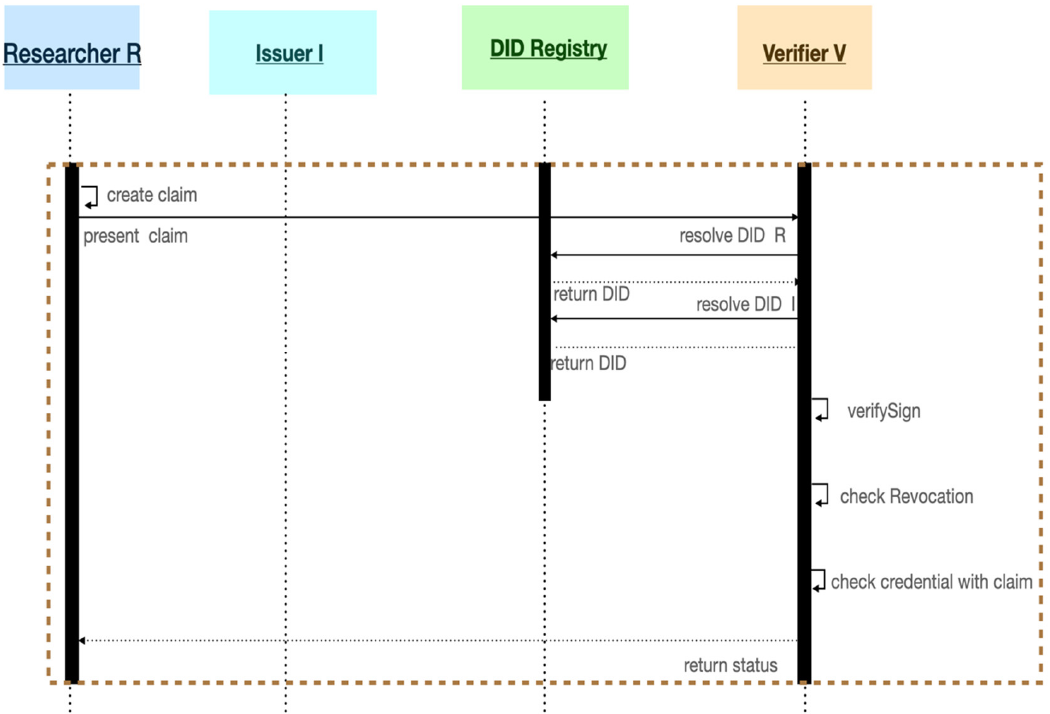
Figure 8. Identity of researcher issued by IRB and verified by CDM provider (play a role as verifier).